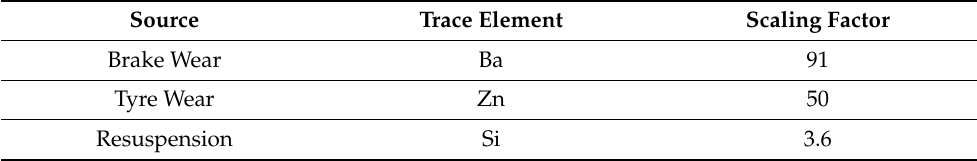
Table 1. Particulate matter (PM) non-exhaust emission trace elements scaling factors [5].